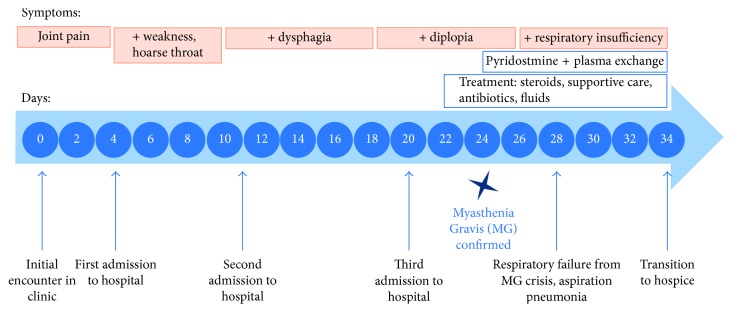
Hospital course.